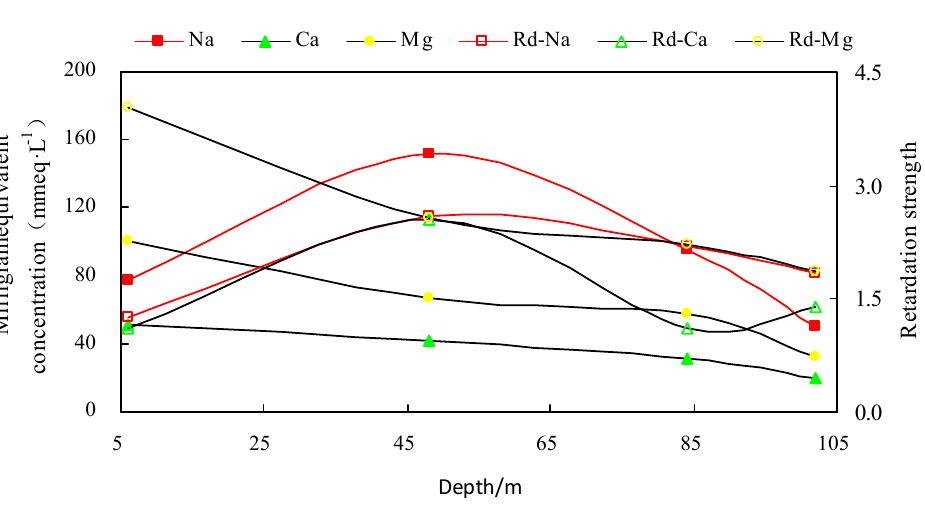
Figure 7. Variation trend of ion content and retardation coefficient of clay at different